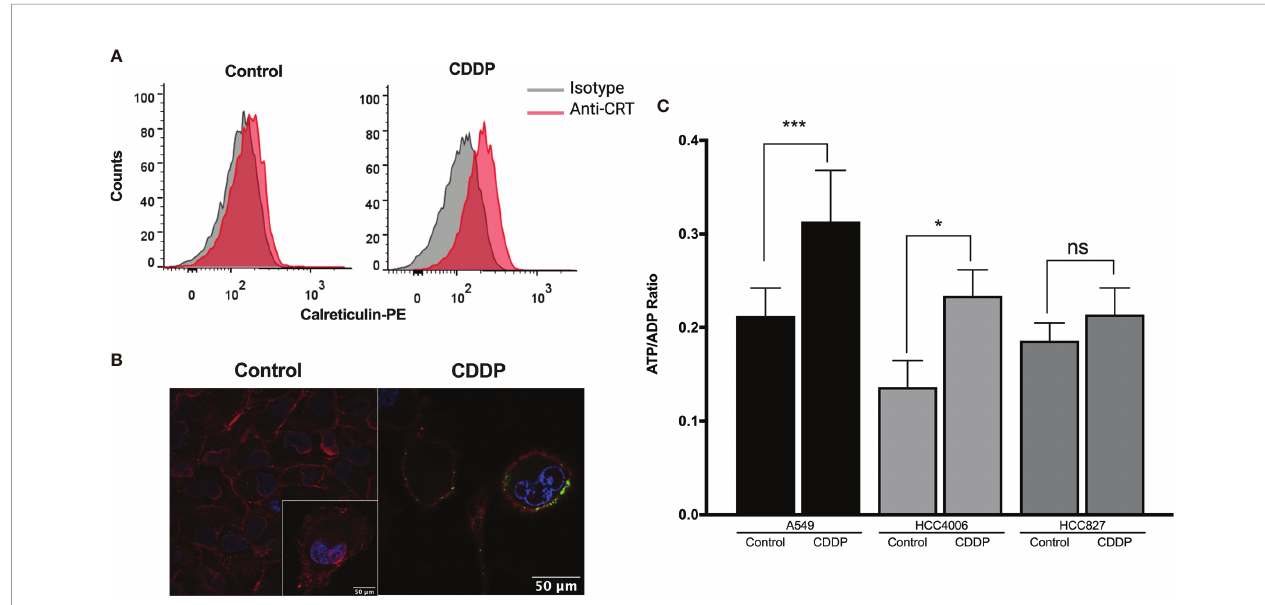
FIGURE 2 | Detection of immunogenic cell death-associated markers in cell lines treated with cisplatin (CDDP). (A) Calreticulin was detected on the cell membrane of A549 viable cells using fl ow cytometry. Representative histograms of control and CDDP-treated cells are shown. (B) Images of confocal microscopy showing calreticulin distribution in control and CDDP-treated cells. Magni fi cation: control, ×400; inset and CDDP, ×600. (C) ADP/ATP ratio obtained when the highest proportion of apoptotic cells was detected. Three experiments were done in triplicate. Data is expressed as mean ± SD. The signi fi cant difference between treatment and control is indicated with asterisks (* p < 0.05, *** p < 0.0005, ns, non-signi fi